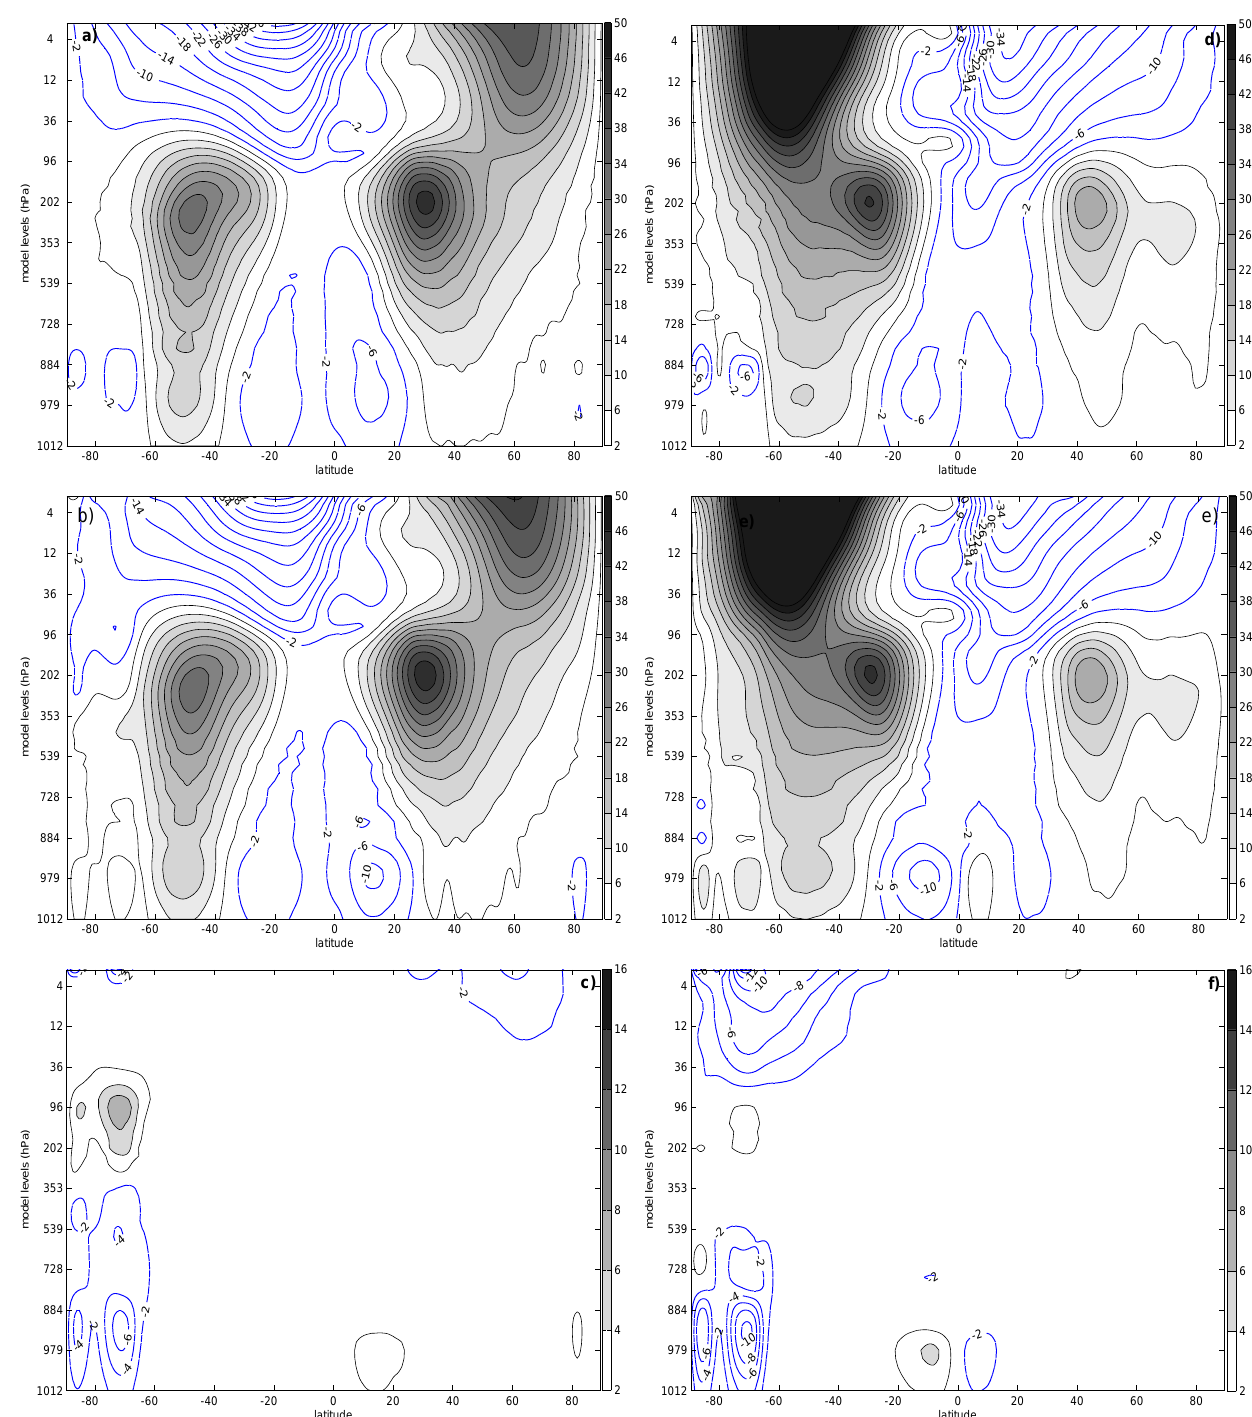
Figure 9. Meridional profile of the zonally averaged (a, d) total, (b, e) balanced and (c, f) unbalanced components of the zonal wind in (a–c) January and (d–f) July. Westerlies are shaded while easterlies are drawn by blue isolines. Contour intervals are 4ms − 1 for the balanced and 2ms − 1 for the IG speeds.